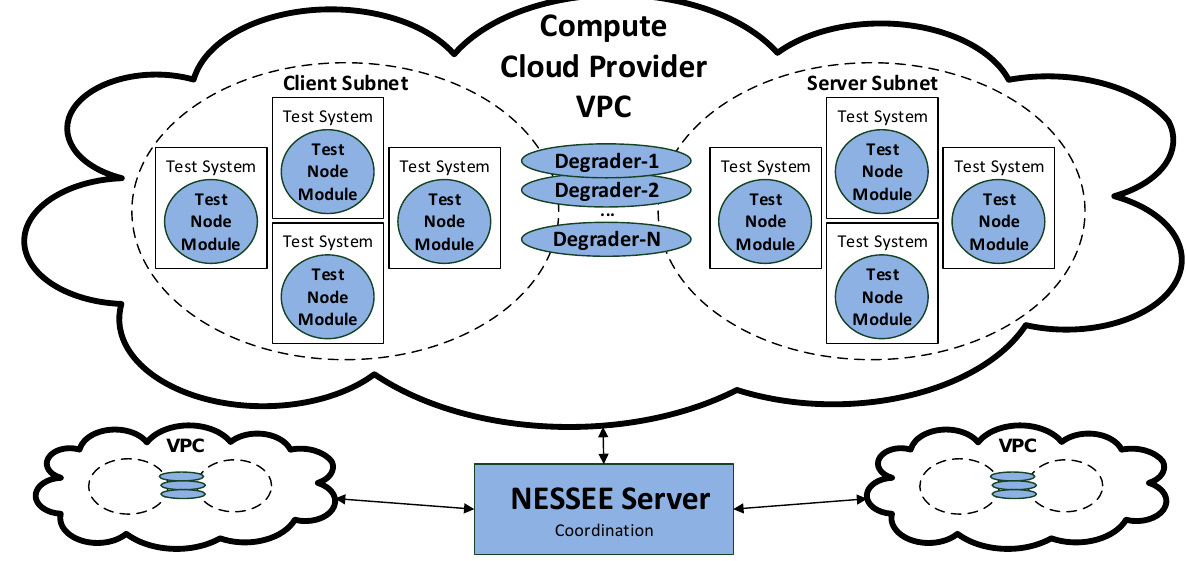
Figure 2: Proposed architecture of the test platform in a Cloud